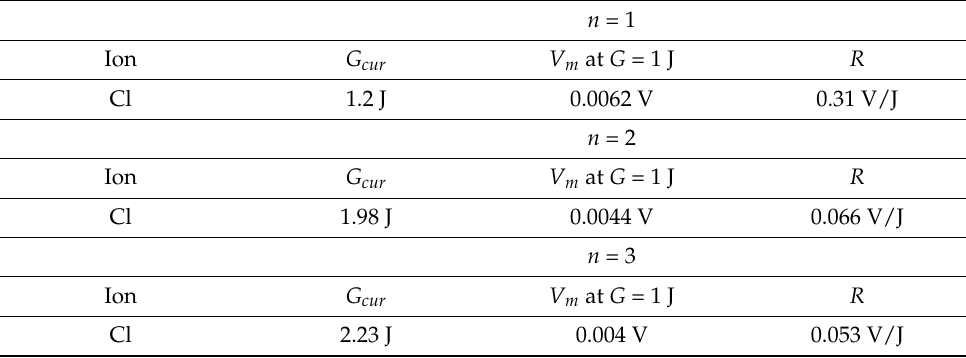
Table 2. The table represents the curving energy point, the membrane potential at G = 1 J, and the average rate of depolarization at different values of gate location n and according to the other setting values in Figure 15.